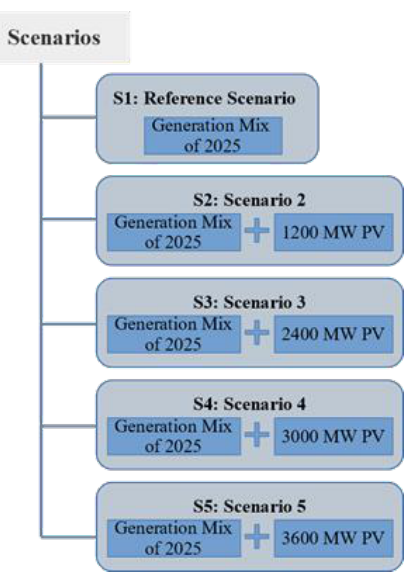
Figure 4. Scenarios with various levels of solar PV penetration.